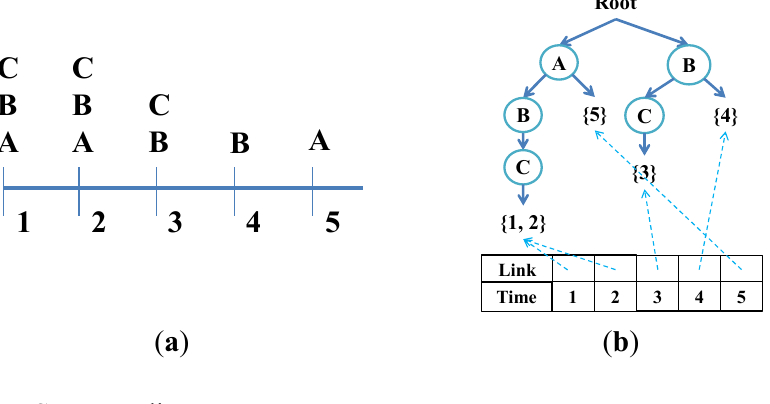
Figure 4. An example tree structure. ( a ) An example of event sequence; ( b ) An example of tree